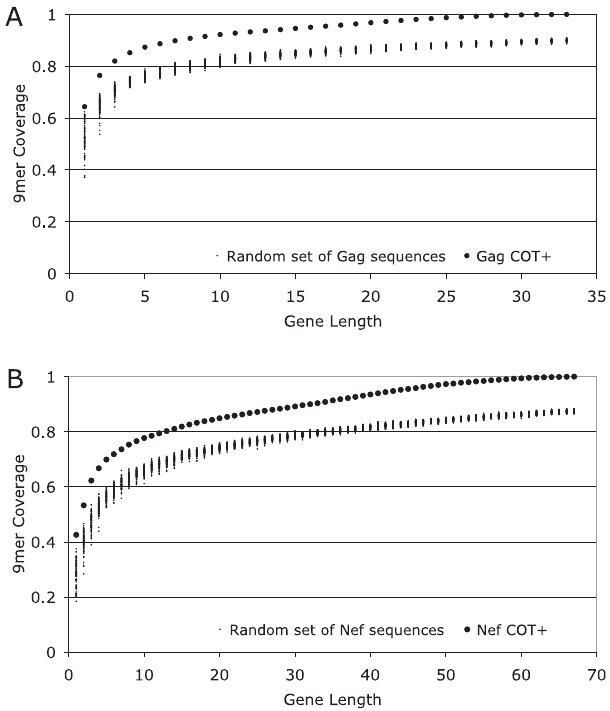
Figure 3. Coverage Comparison between COT þ and 100 Randomly Sampled (without Replacement) Sets of Sequences of the Same Length The comparison at the single gene length is for HIV-1 subtype B Gag and Nef, and measures the COT sequence against randomly sampled database sequences. The COT þ captures all known variation in the training dataset at 33 gene lengths for Gag (A) and 67 gene lengths for Nef (B). Neither Gag nor Nef randomly sampled datasets will reach 100% coverage until 100% of the data is